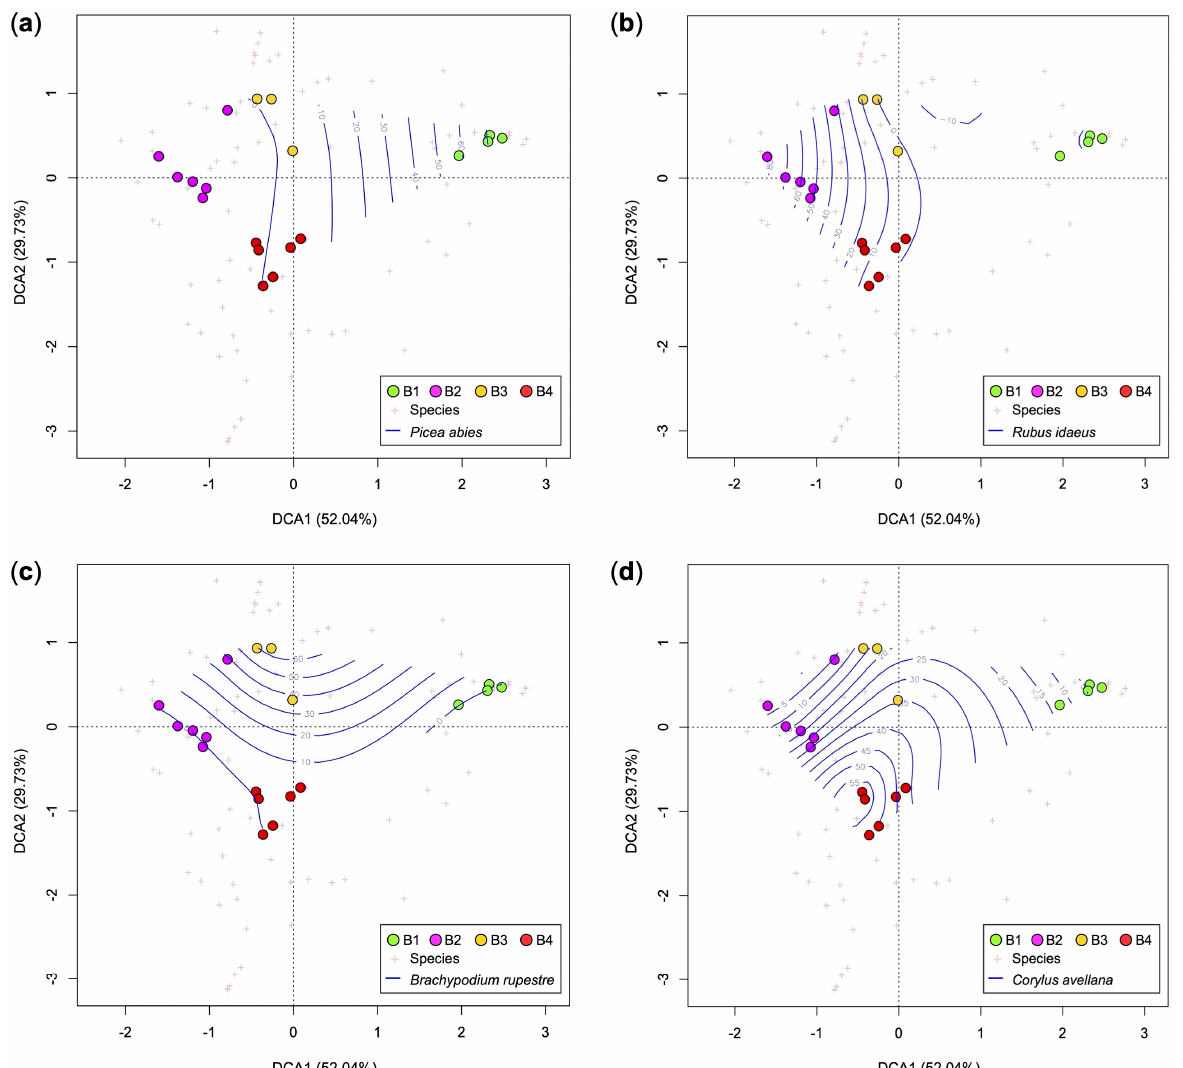
Figure 7. DCA biplots of phytosociological relevés (dots) overlapped with plant cover contour lines (blue lines with percentage of plant cover) of some diagnostic species of each cluster: Picea abies ( a ), Rubus idaeus ( b ), Brachypodium rupestre ( c ) and Corylus avellana ( d ). Key: B1, Picea abies forest; B2, Astrantio-Corylion avellanae ; B3, Brachypodium rupestre-Astragalus glycyphyllos community; B4, Rubetum idaei .